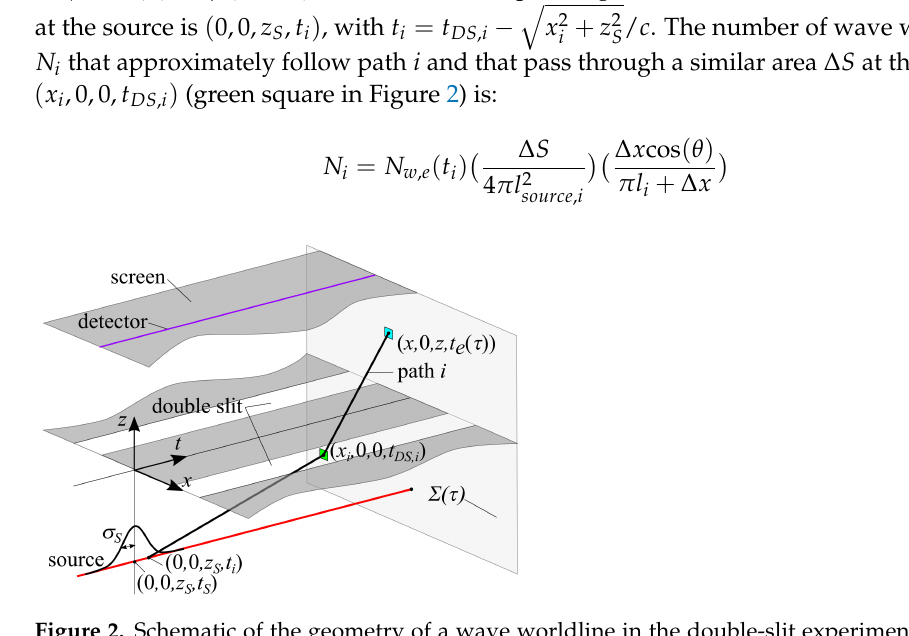
Figure 2. Schematic of the geometry of a wave worldline in the double-slit experiment. A single path i is shown that originates from the emission event ( 0,0, z S , t i ) at the source and passes through the double slit in the deflection event ( x i ,0,0, t DS , i ) . The hypersurface Σ ( τ ) is indicated, which contains the endpoint ( x ,0, z , t e ( τ )) of the worldline. Additionally, the double-slit aperture, the source worldline (red), and a screen with a detector worldline (purple) are